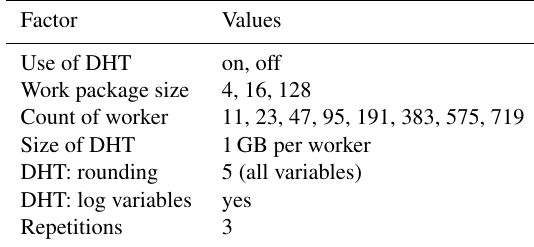
Table 3. Summary of investigated factors for the performance eval- uation of POET in the SimDolKtz